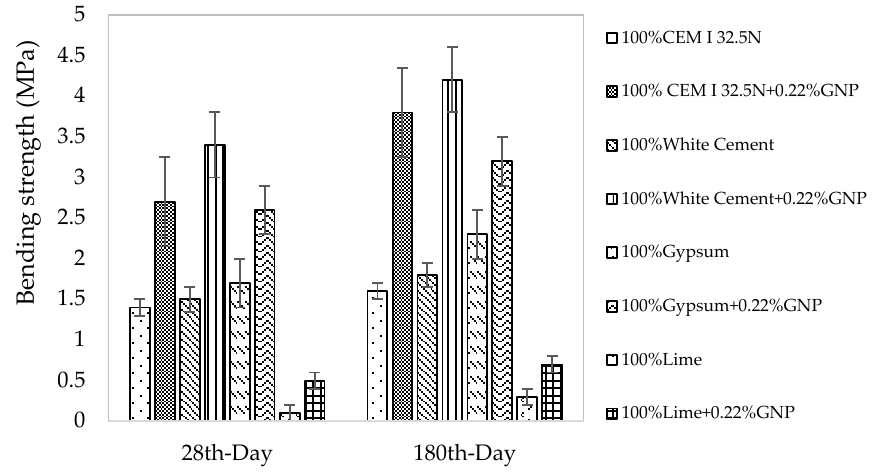
Figure 7. Changes in the bending strength of various types of mortars and the binder type, binder percent, supplement type, and supplement percent.